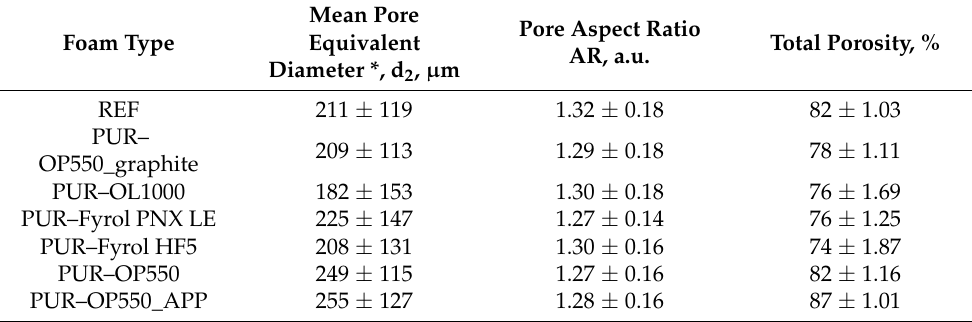
Table 4. Structural parameters of foams by flame-retardant type.